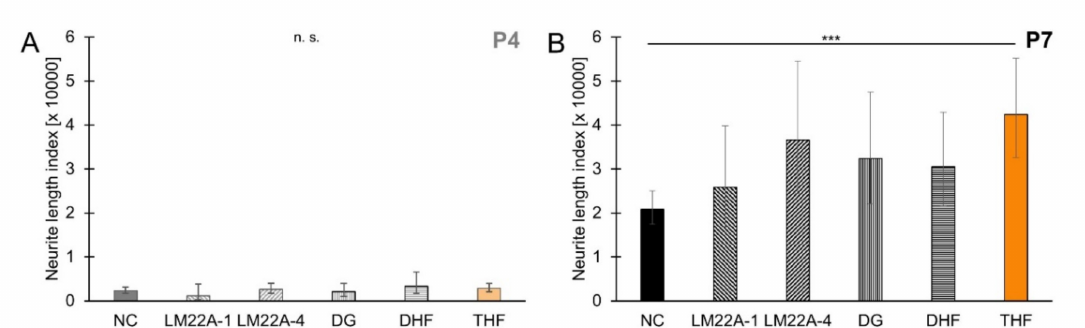
Figure 3. Small-molecule tropomyosin receptor kinase B (TrkB) agonist-stimulated neurite outgrowth in spiral ganglion explants from P4 and P7 mouse cochlea. P4 ( A ) and P7 ( B ) SGEs were cultured in medium devoid of neurotrophic compounds (NC) or in medium supplemented with 1 µ M LM22A-1, LM22A-4, deoxygedunin (DG), 7,8-dihydroxyflavone (DHF), or 7,8,3 (cid:48) -trihydroxyflavone (THF). After 4 DIV, SGEs were fixed and stained for NF200. Neurite outgrowth was quantified. Bars represent geometric means in µ m; error bars indicate ± upper and lower 95% confidence intervals for the mean; one-way ANOVA, Dunnett post-hoc test, n. s. = not significant ( p > 0.05), *** p <